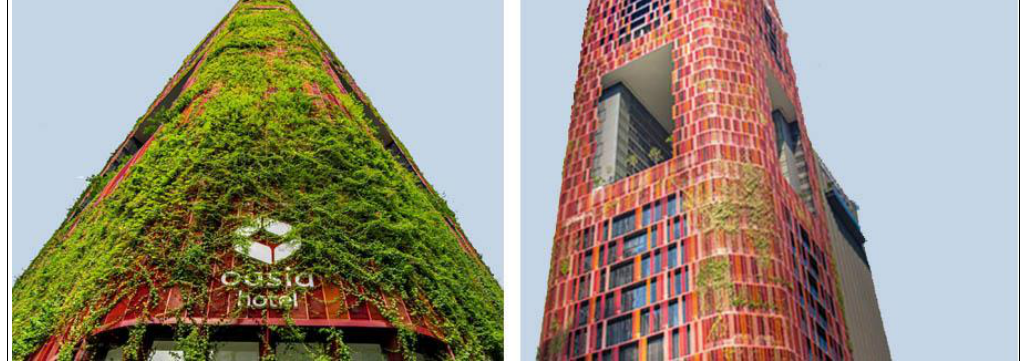
Figure 29. Oasia Hotel Downtown: Green facade (photograph by authors).